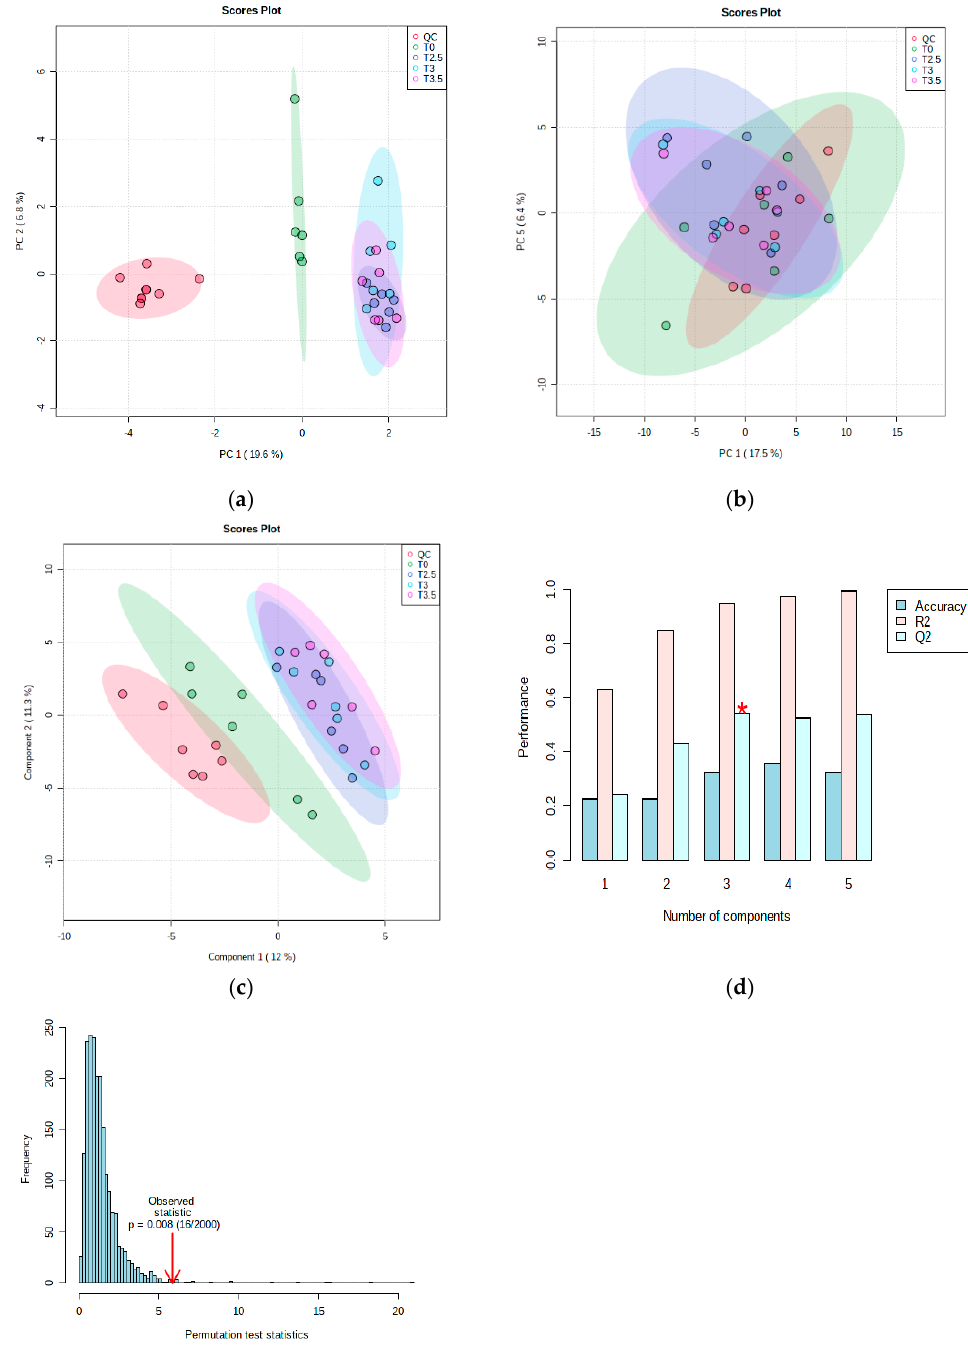
Figure 4. Multivariate analysis for metformin plasma dataset A: ( a ) principal component analysis (PCA) in positive mode; ( b ) PCA in negative mode; ( c ) partial least square discriminant analysis in negative mode; ( d ) cross-validation in negative mode (Q2 = 0.540, R2 = 0.948); ( e ) permutation test in negative mode ( p < 0.05).